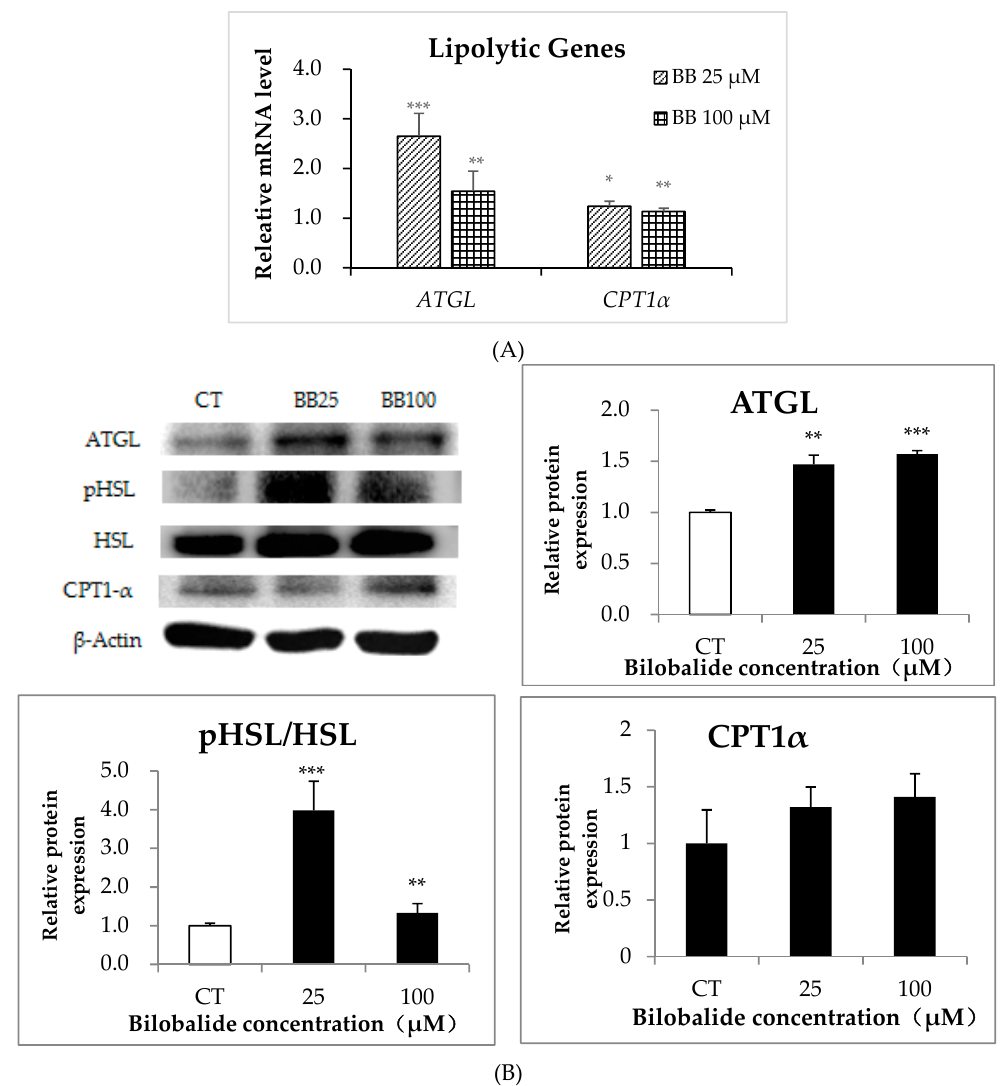
Figure 6. Effects of different bilobalide concentrations on the expression of lipolytic genes. 3T3-L1 cells were differentiated to adipocytes and treated with 0, 25, or 100 μ M bilobalide for 24 h. (A) The relative mRNA expression of ATGL , HSL , and CPT1 α was quantified by qRT-PCR. (B) Western blot was performed to determine the protein levels of ATGL, HSL, phosphorylated HSL, and CPT1 α . Protein bands were quantified by Image Lab software, and histograms represent quantified band intensities for each protein. Data represent the mean ± standard deviation (n = 3). * p < 0.05, ** p < 0.01, *** p < 0.001.